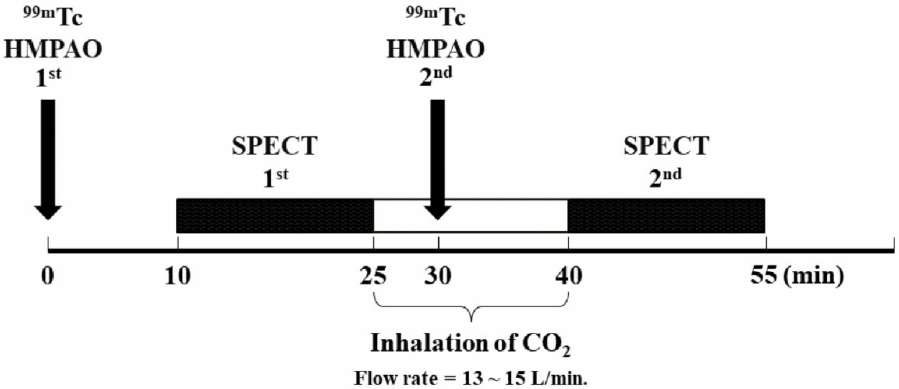
Figure 1. The acquisition protocol for the same day (one-day) consecutive first (20 mCi) and second (40 mCi) technetium 99m-labeled hexamethyl-propyleneamine-oxime ( 99m Tc-HMPAO) single-photon emission computed tomography (SPECT) imaging. A gas mixture including about 5% CO 2 gas was administered through each subject’s nose. The flow rate, controlled by a gas regulator, was 13–15 L per minute during approximately 15 min. Each scan time was 15 min (25 s × 32 steps, step-and-shoot mode) for each first and second SPECT.